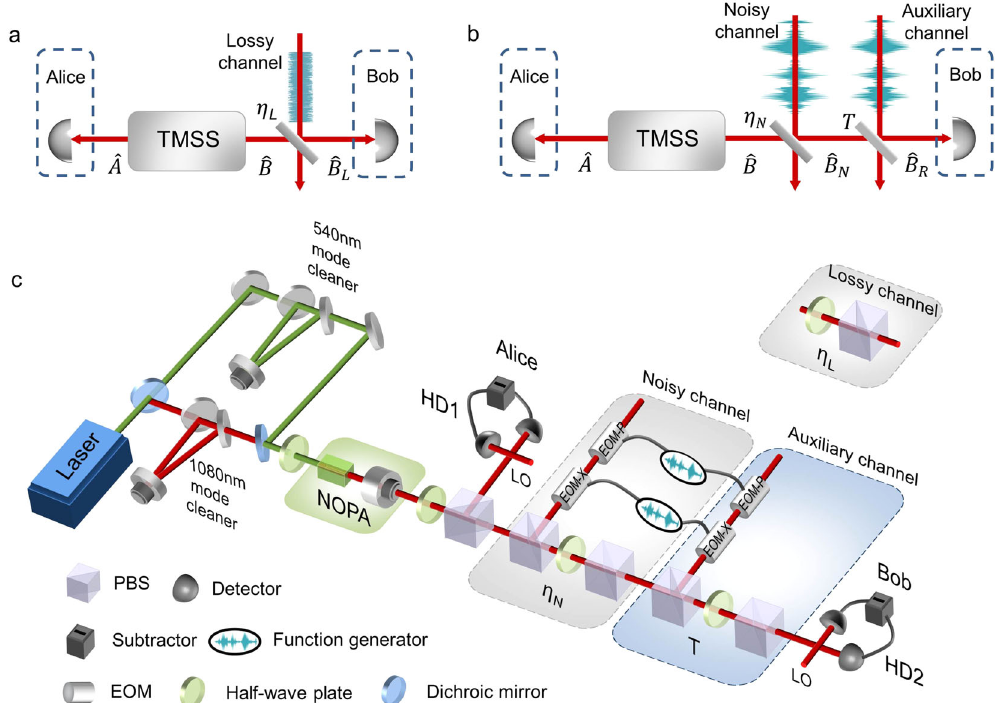
Fig. 1 The principle of experiment. a Schematic of EPR steering in lossy channel. One mode of the two-mode squeezed state (TMSS) ^ A is kept by Alice, the other mode of TMSS ^ B is distributed to Bob over a lossy channel which is experimentally mimicked by a beam splitter, the vacuum mode couples into system from the other input port of the beam splitter. The transmission ef fi ciency of the lossy channel is η L . b Schematic of disappearance and revival of EPR steering. Mode ^ B is distributed to Bob over a noisy channel with an excess noise higher than the vacuum noise. The transmission ef fi ciency of the noisy channel is η N . An ancillary beam with noise correlated to noisy channel couples with the transmitted mode on a beam splitter with transmission coef fi cient T . c The experimental setup. A pure − 3 dB TMSS at the sideband frequency of 3 MHz is generated by a nondegenerate optical parametric ampli fi er (NOPA). Alice and Bob perform homodyne measurement on their states, respectively. An ancillary beam is used to revive the EPR steering. PBS polarization beam splitter, LO local oscillator, EOM electro- optic modulator, HD